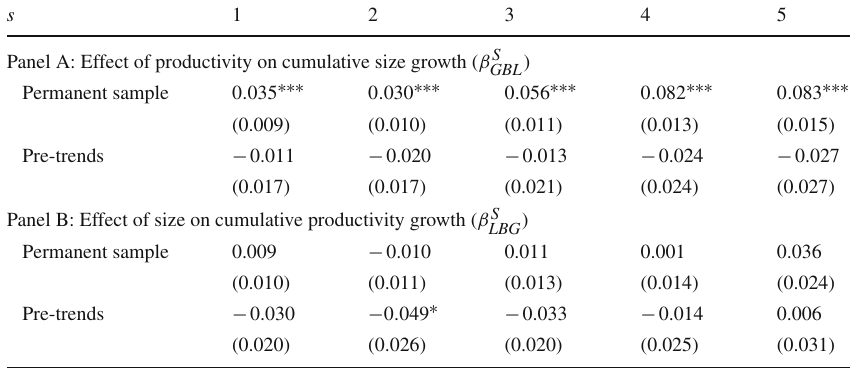
Table 6 Estimated GBL and LBG effects—robustness